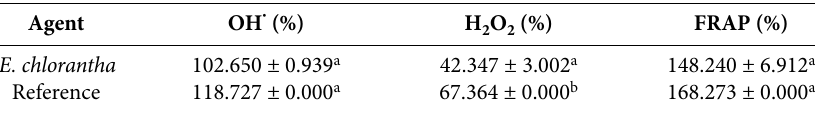
Table 3. Percentage OH – , H 2 O 2 and FRAP Scavenging Activity of E. chlorantha Extract